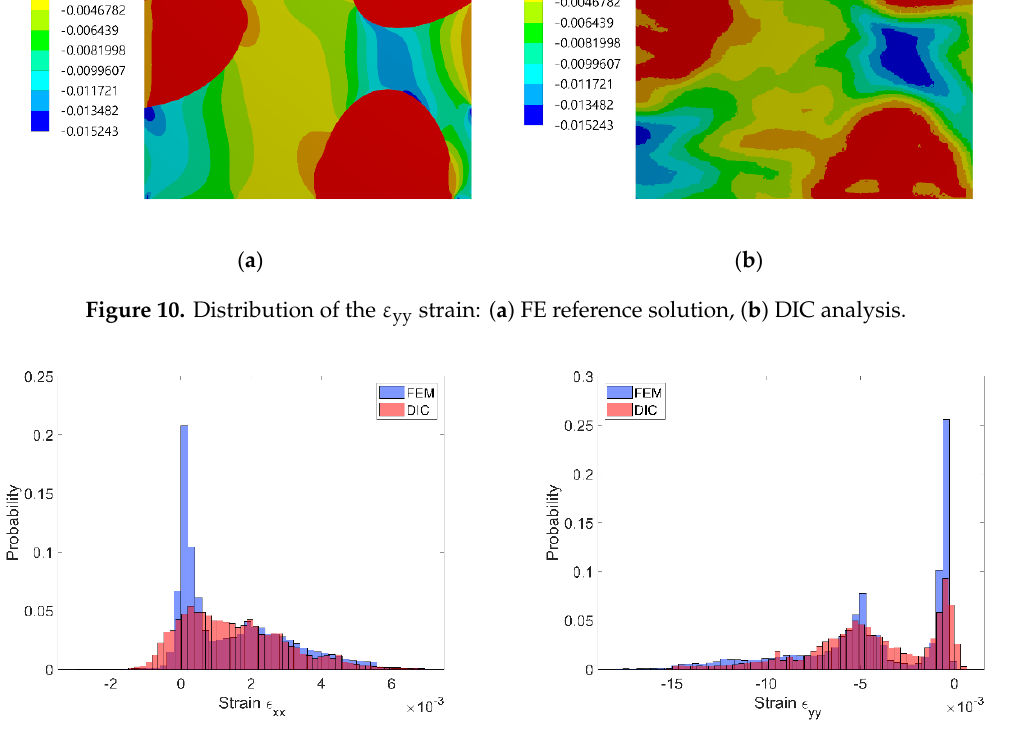
Figure 11. Histograms representing the strain distributions determined by DIC and FE reference solution: ( a ) ε xx component, ( b ) ε yy component.